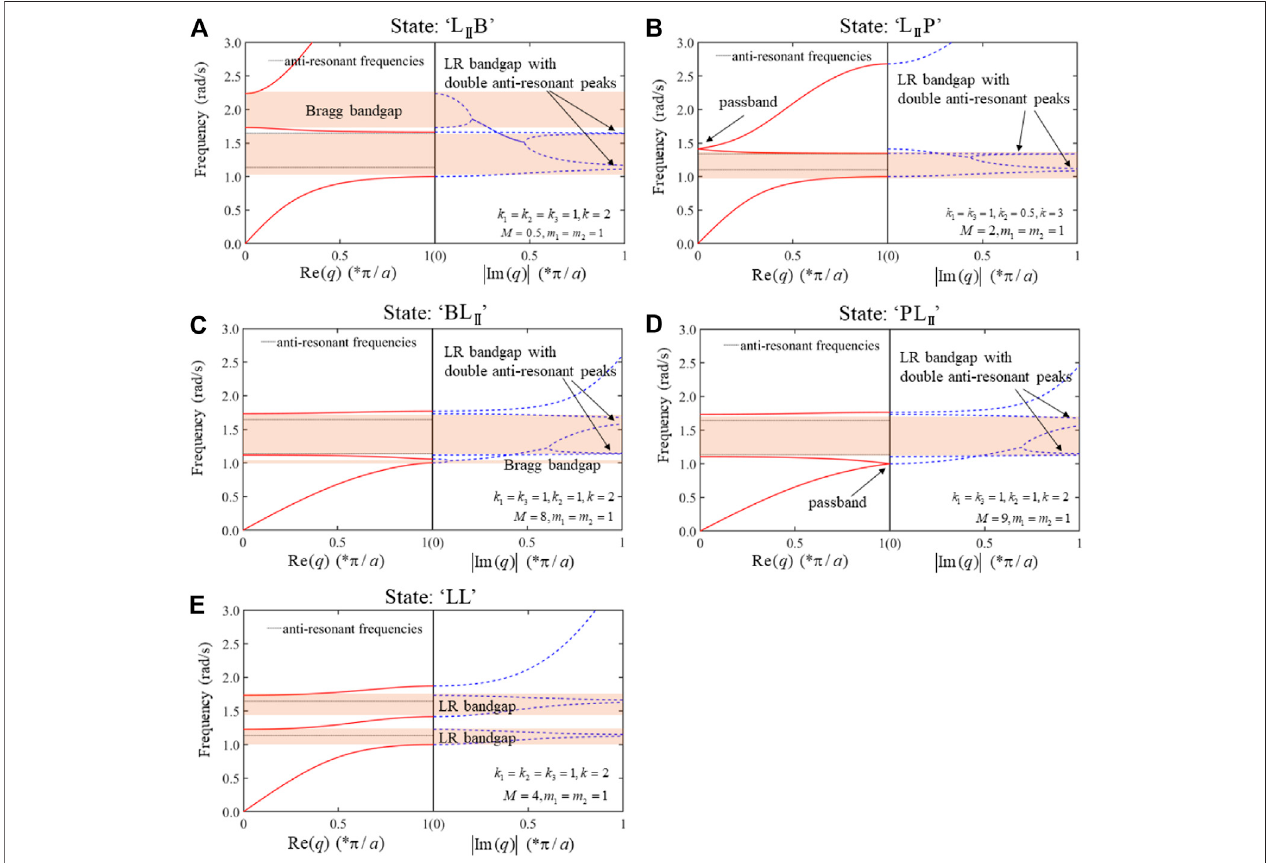
FIGURE 7 | Different bandgap states when there are two anti-resonant frequencies in the mass-coupled monatomic/triatomic chain system. (A) State “ L Ⅱ B ” : the fi rst bandgap is a LR bandgap with double anti-resonant peaks and second one is Bragg bandgap. (B) State “ L Ⅱ P ” : the second Bragg bandgap becomes a passband. (C) State “ BL Ⅱ ” : Bragg bandgap and LR bandgap with double anti-resonant peaks. (D) State “ PL Ⅱ ” : the fi rst Bragg bandgap vanishes. (E) State “ LL ” : there are two LR bandgaps.